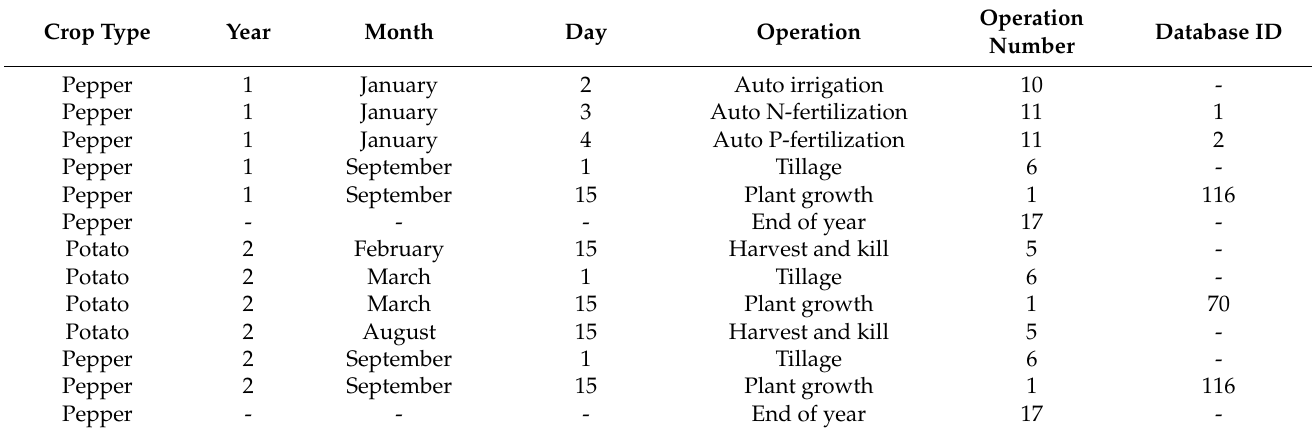
Table 3. An example of a pepper-potato rotation